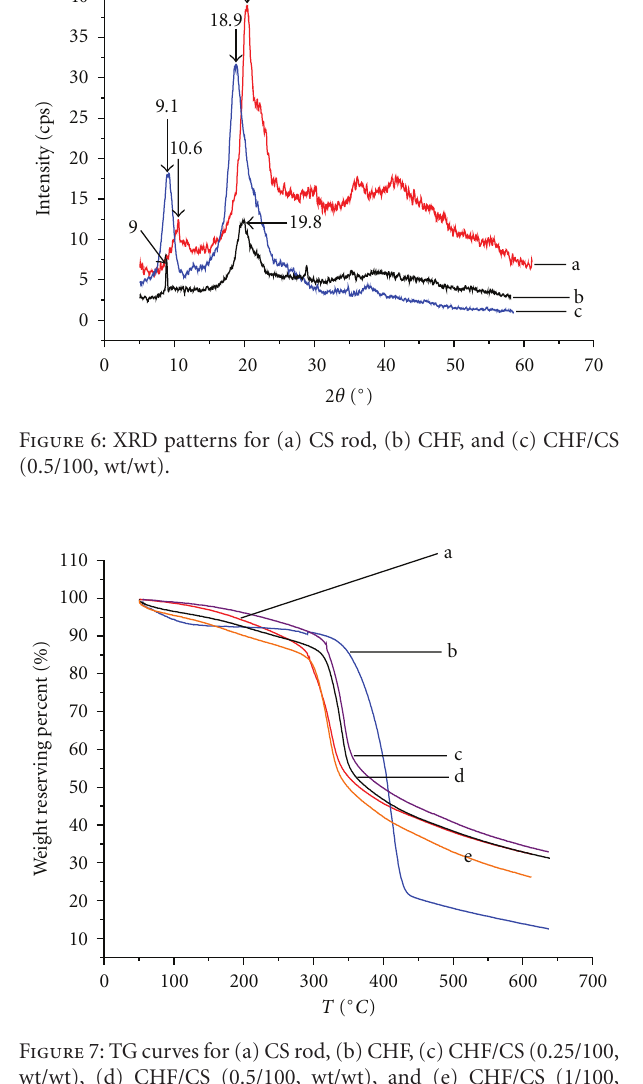
Figure 9: Bending strength of CHF/CS composites influenced by content of